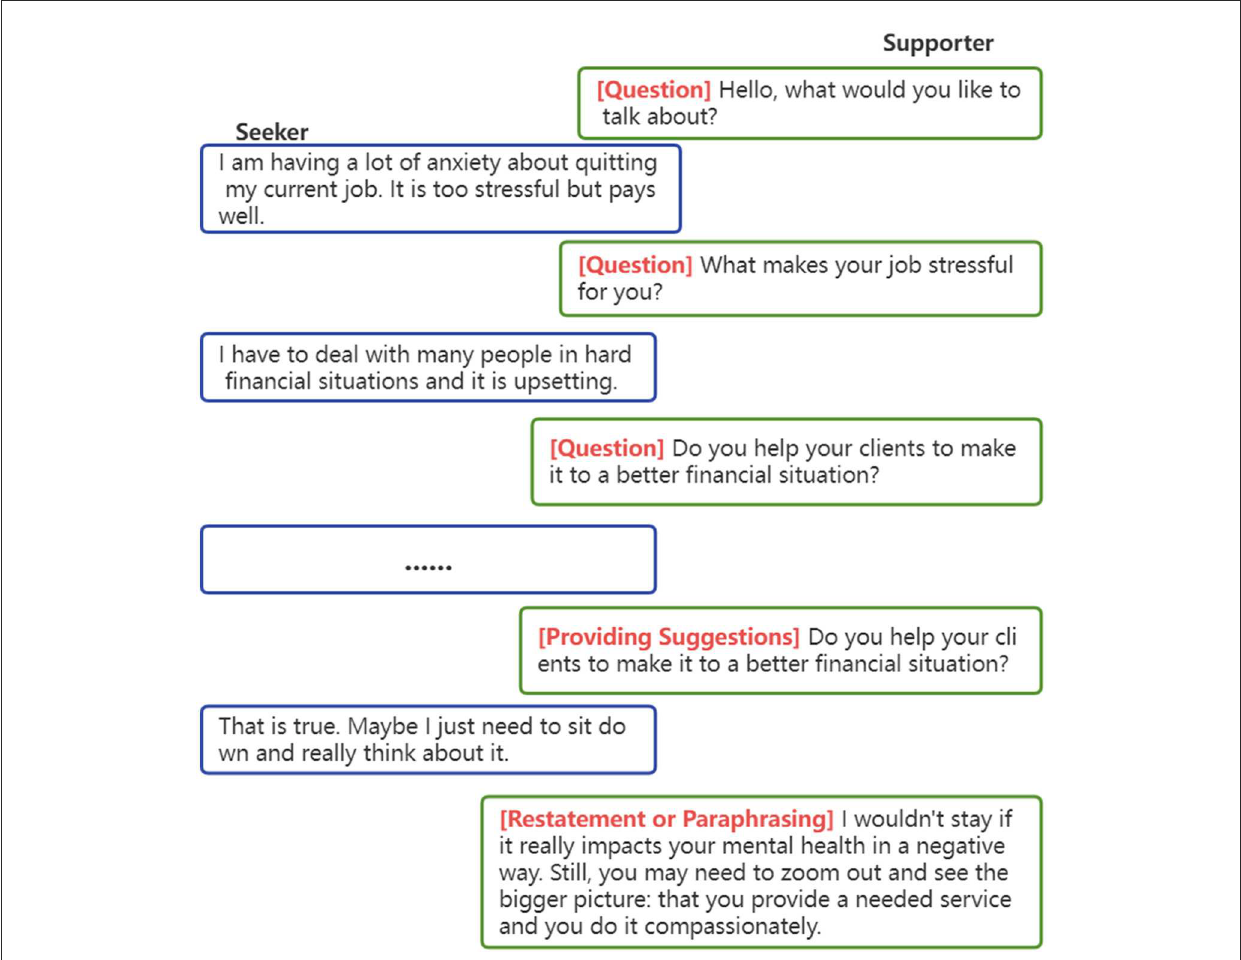
FIGURE2 An example to show a multi-turn emotional support conversation between supporter and seeker. The red parts are strategies the supporter